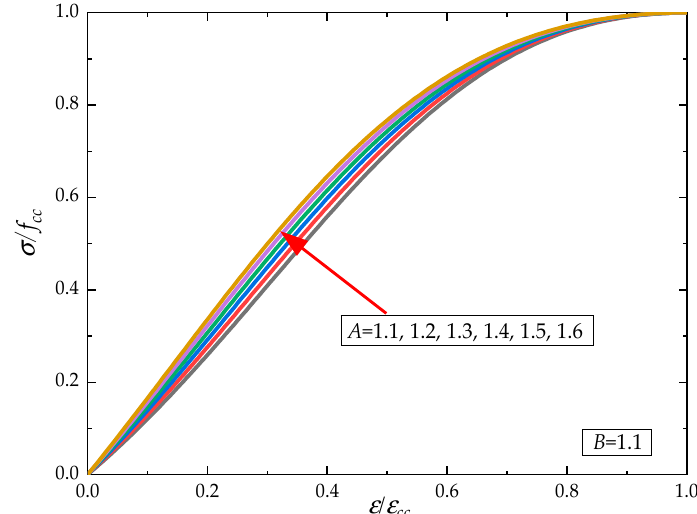
Figure 12. Effect of model parameter A on the ascending portion of the complete curve.